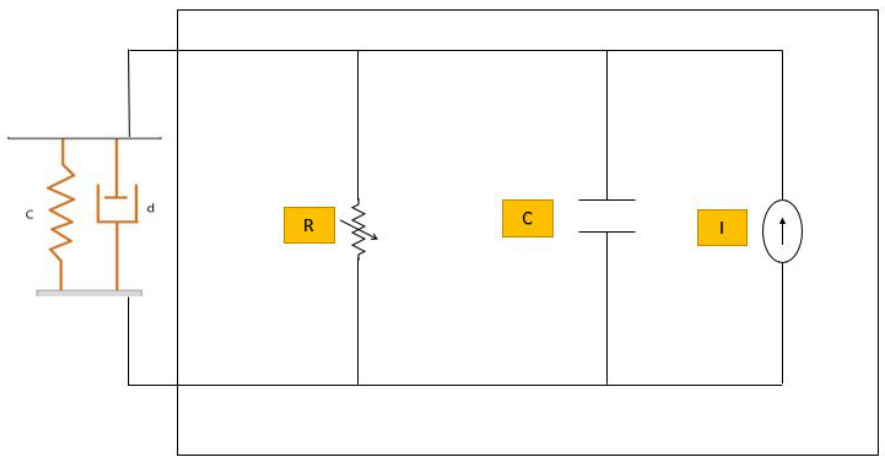
Figure 2. Electrical circuit of mechanical-based PEH. PZT is shocked mechanically (i.e., direct effect of piezoelectricity), which overcomes the internal resistance R o , the poling phenomenon occurs, and energy is